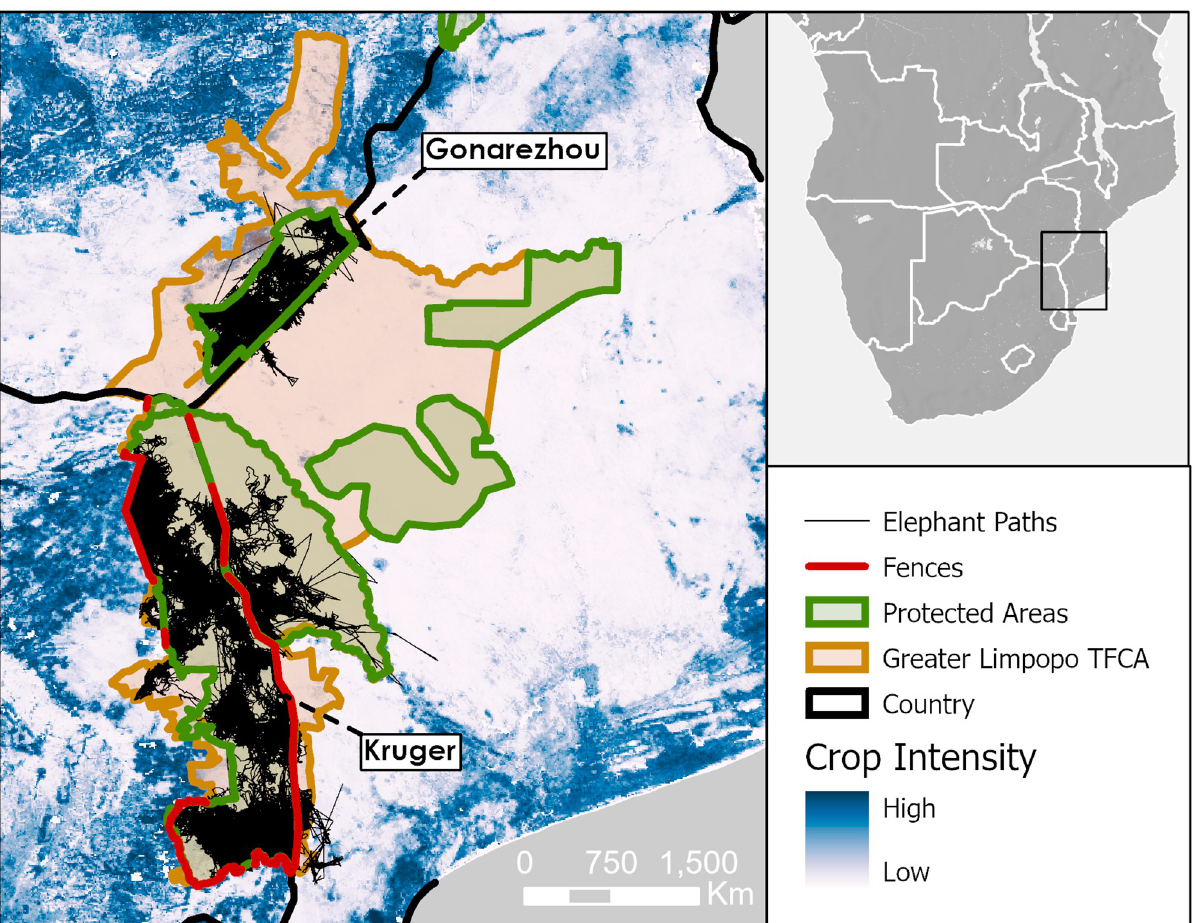
Fig 7. Map of elephant paths and crop probability in the Limpopo cluster. Telemetry paths of elephants in Kruger National Park (South Africa), the adjacent Limpopo National Park (Mozambique), and Gonarezhou National Park (Zimbabwe) overlaid on a map of crop probability (blue) [33]. Fences are marked in red [4], and the WDPA I-VI protected area boundaries are green [35]. The proposed Greater Limpopo Transfrontier Conservation Area is in